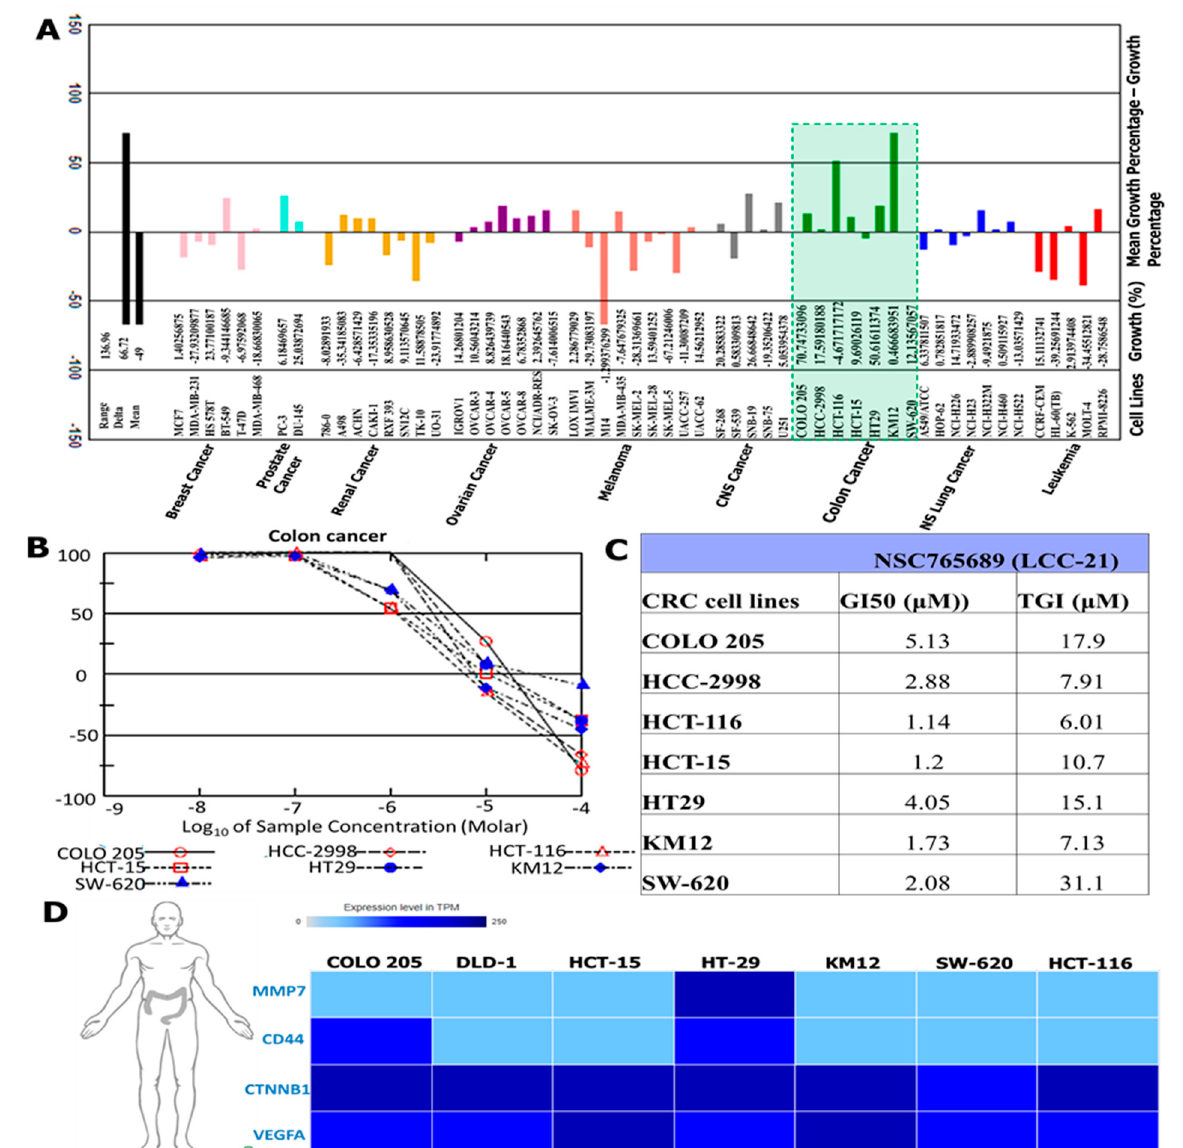
Figure 13. NSC765689 (LCC ‐ 21) demonstrates anticancer activities on colon cancer cell lines. ( A ) An initial 10 μ M single ‐ dose treatment displayed anti ‐ cancer effects of LCC ‐ 21 on colon cancer cell lines. ( B , C ) LCC ‐ 21 was able to effect 50% growth inhibition (GI50) and tumor growth inhibition (TGI) at dose ‐ dependent treatment. ( D ) Overexpression of VEGF ‐ A, CTNNB1, CD44, and MMP7 genes in different colon cancer cell lines.